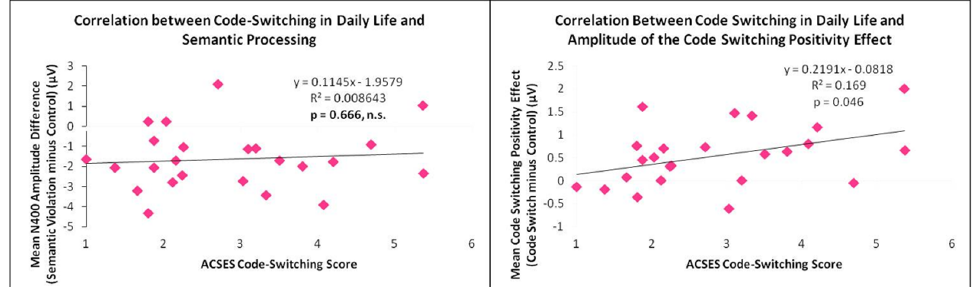
Figure 5. Correlations of frequency of code-switching with the amplitude semantic congruity effect on the N400 ( left panel ) and the amplitude of the code-switching positivity (320–650 ms; right panel